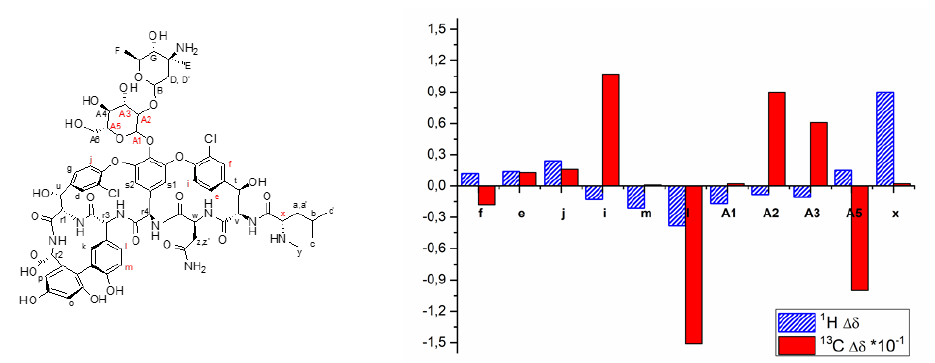
Figure 2. On the left: Van structure. On the right: Most significative chemical shift variations (ppm) of 1 H and 13 C resonances between free Van and the [Ir(Cp*)(Van)Cl] complex in the NMR spectra (see SI for complete assignment).